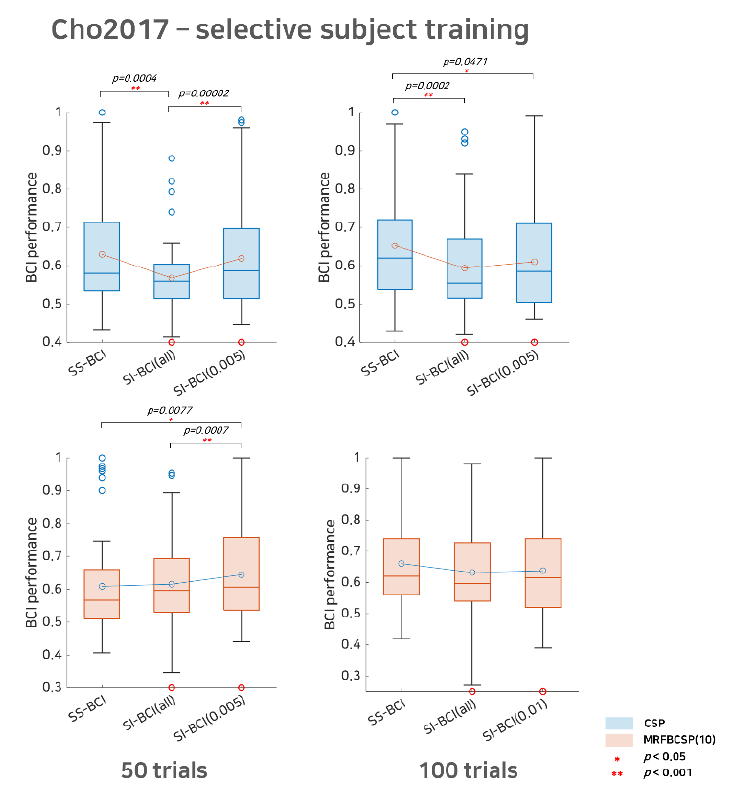
Figure 3. Comparative analysis of SS BCI and SI BCI performance with the Cho2017 dataset. This represents SS BCI performance, SI BCI performance using all subjects available (SI BCI-All), and SI BCI performance using selective subject training (SI BCI- α ) for the Cho2017 dataset. Blue colored box plots indicate the CSP method and red colored box plots indicate the MRFBCSP method. Blue colored circles in the boxplot denote outliers and the red colored circle indicates a subject (s35) who showed ipsilateral activation for the CSP during motor imagery.